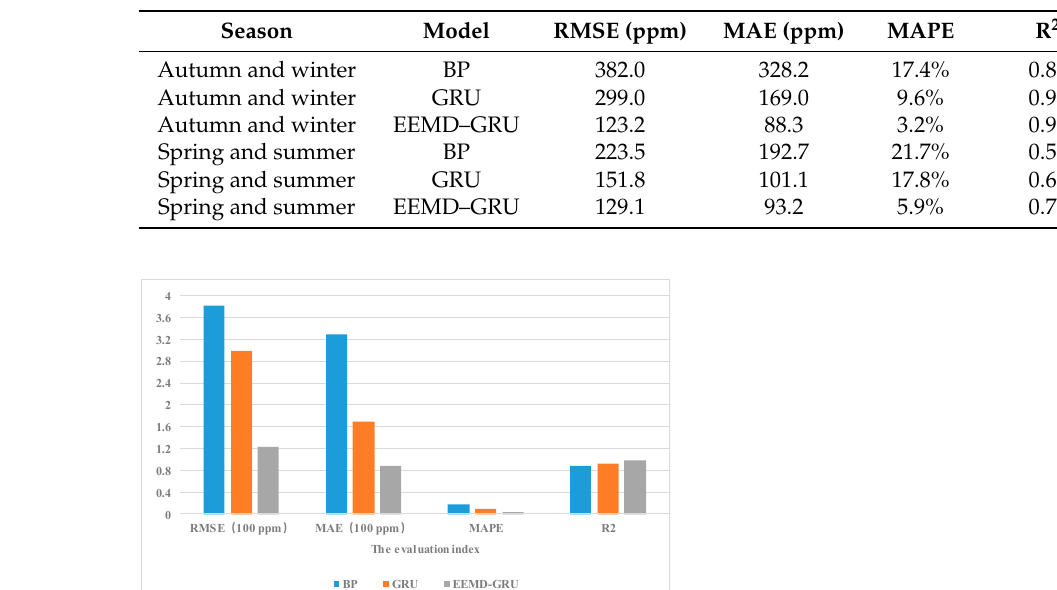
Table 5. Comparison of prediction errors of the three models.